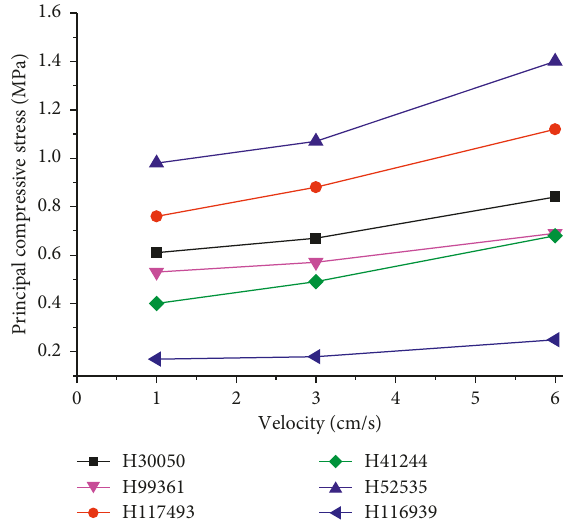
Figure 22: The PCS curve of local members under different peak particle velocities.